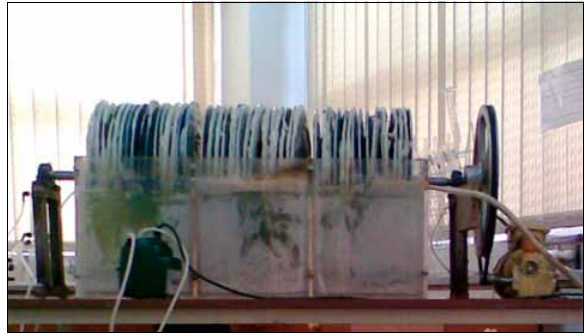
Fig. 1. The RBC with developed biofilm after